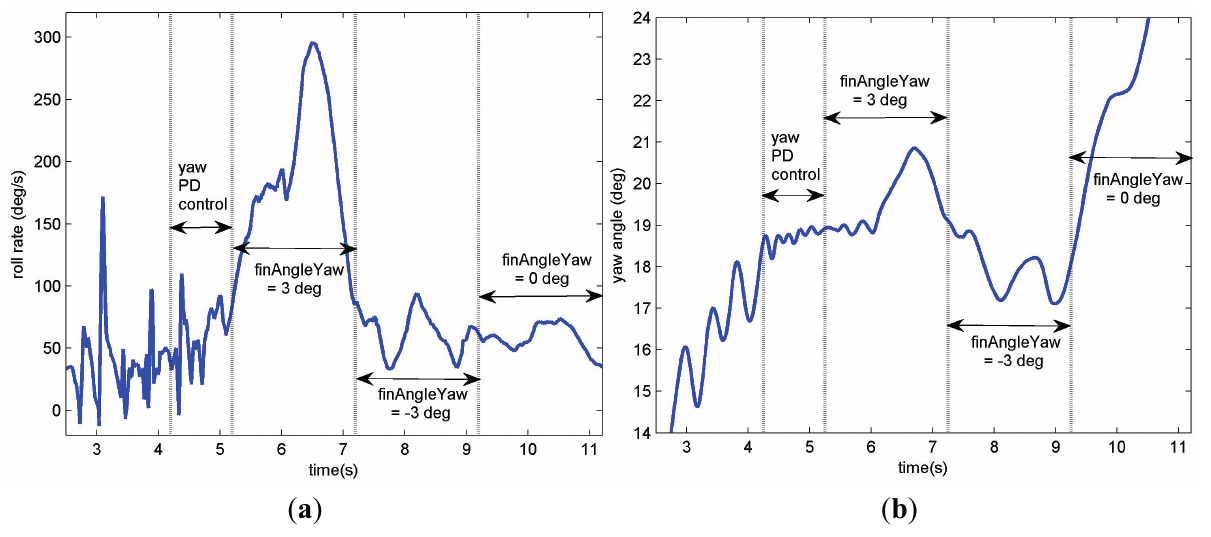
Figure 22. Closer view of control results ( a ) roll rate response ( b ) yaw angle